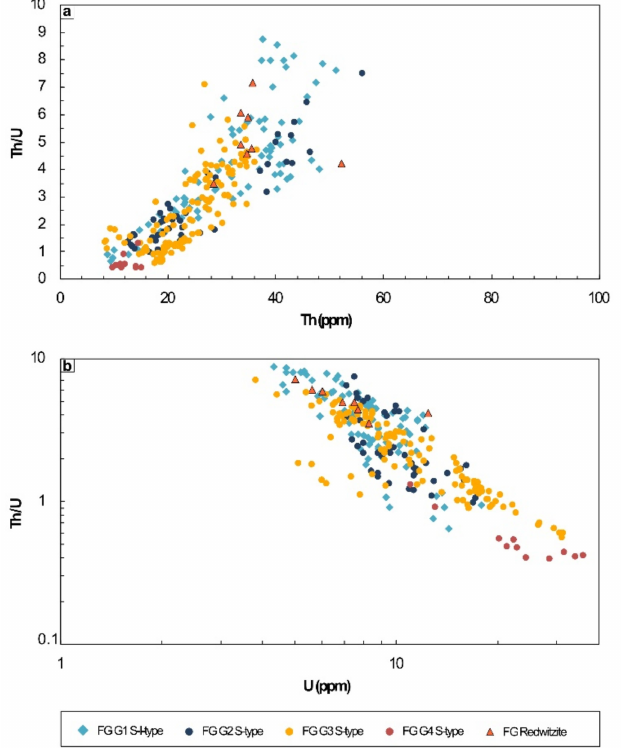
Figure 4. Th/U versus Th ( a ) and Th/U versus U ( b ) for the Fichtelgebirge granites and diorites.